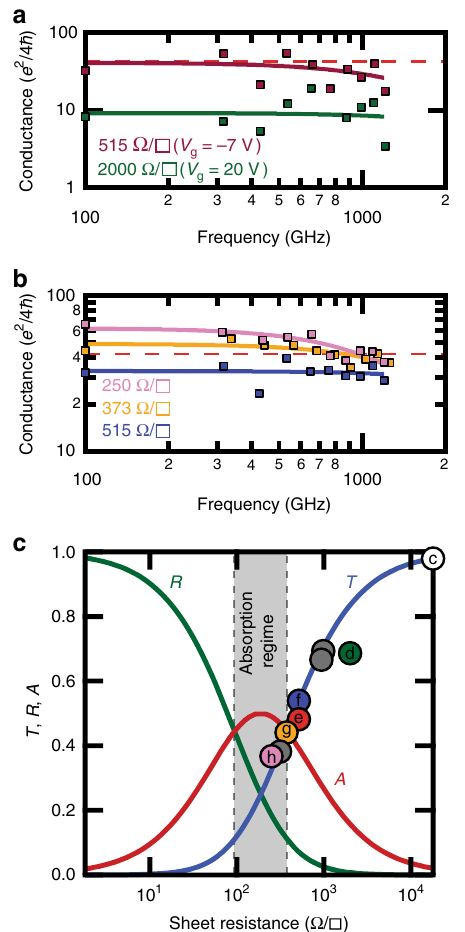
Fig. 4 Drude conductance and strong absorption. a , b The AC conductance values calculated by fi tting the measured transmittance peaks for both electrically and chemically modi fi ed devices from Fig. 3 are plotted as squares. Drude model trends estimated from the frequency-dependent AC conductance data are plotted as solid lines. c The measured transmittance peak values (at ~ 655 GHz) are plotted as a function of sheet resistance. Colored (labeled) circles represent data from devices shown above, gray circles are from devices measured, but not displayed in Fig. 3, and the white circle represents the control sample. The theoretical transmittance, absorbance and re fl ectance values calculated from the half-wave resonance case for a device on a substrate are plotted as solid lines. The transmittance value becomes less than the absorbance value at sheet resistance values < 377 Ω / □ , marking the beginning of the absorption